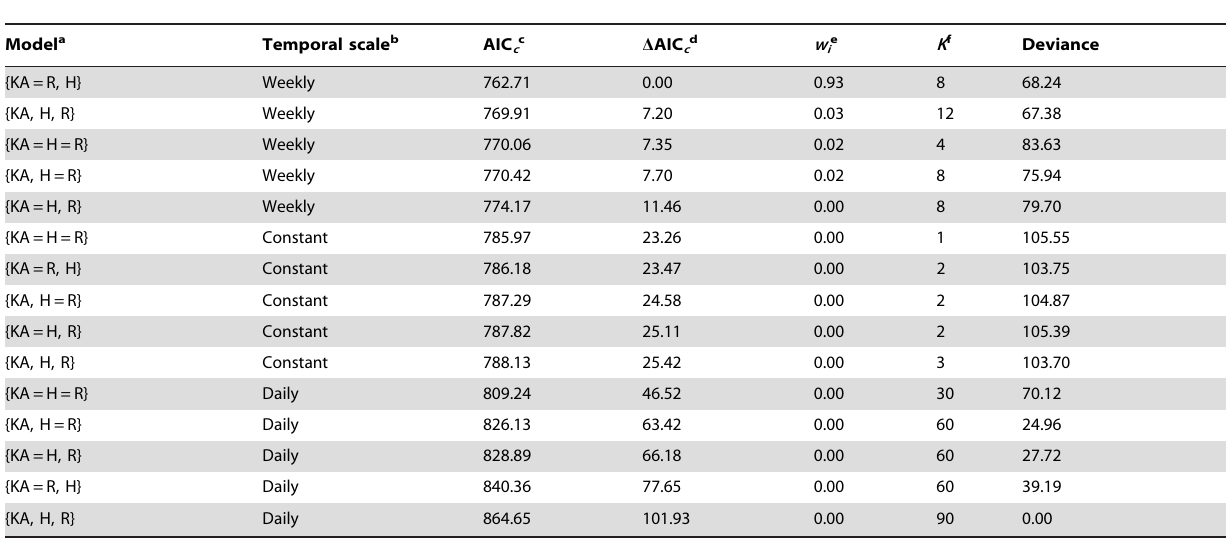
Models compared and contrasted survival rates among groups and time-dependency. a KA=known-age newborn, R=Robinette [21], and H=Haskell [17] neonatal-age model. b Temporal scale represents constant, daily, or weekly survival among intervals. c Akaike’s Information Criterion corrected for small sample size [55]. d Difference in the AIC c value of the top-ranked model and that of the model under consideration. e Akaike weight [55]. f Number of parameters.